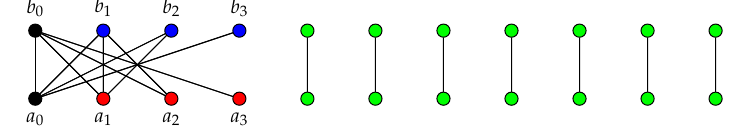
Figure 5. The strong resolving graph F SR of the graph illustrated in Figure